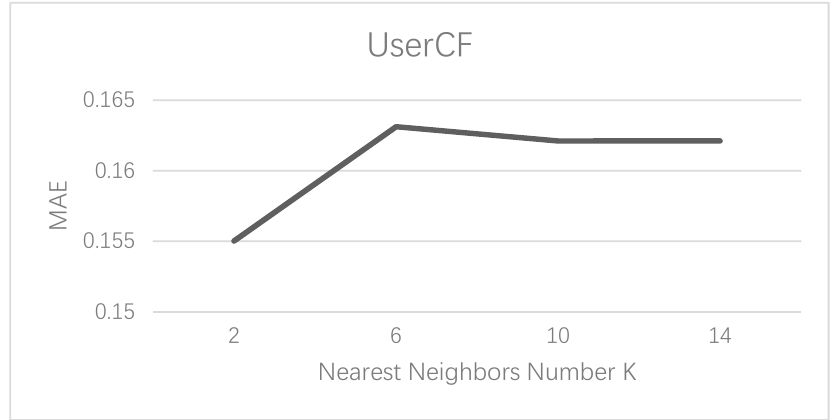
Figure 6. The influence trend of K on mean absolute error (MAE).